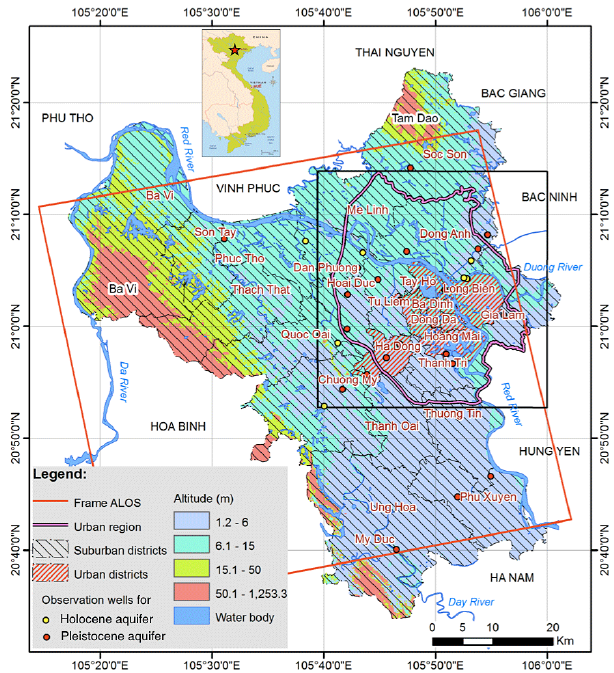
Fig. 1. Map of Hanoi City urban region, with location of urban and suburban districts (after NARENCA, 2009). The black box corre- sponds to the area under study with the InSAR approach in Fig.